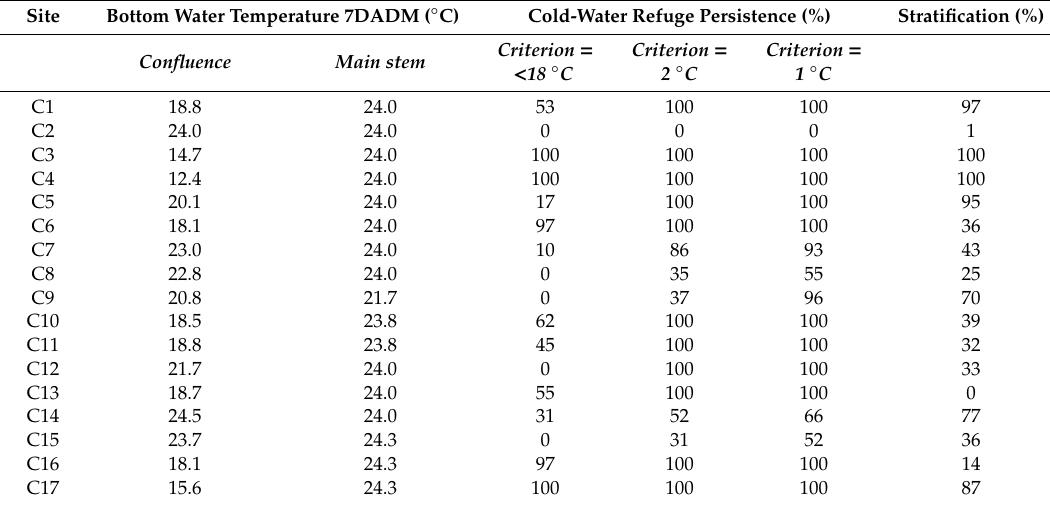
Table 4. Seven-day average daily maximum (7DADM) water temperature at main stem and confluence sites where instream loggers were deployed at the bottom of the river. Cold-water refuge persistence (percentage of time) is presented for ambient and physiological criteria based on whether the 7DADM confluence temperatures were (1) 1 or 2 ◦ C cooler than the 7DADM main stem temperature, or (2) below 18 ◦ C. Stratification is defined as the percentage of time when hourly di ff erences between surface and bottom water temperatures are equal or greater than 2 ◦